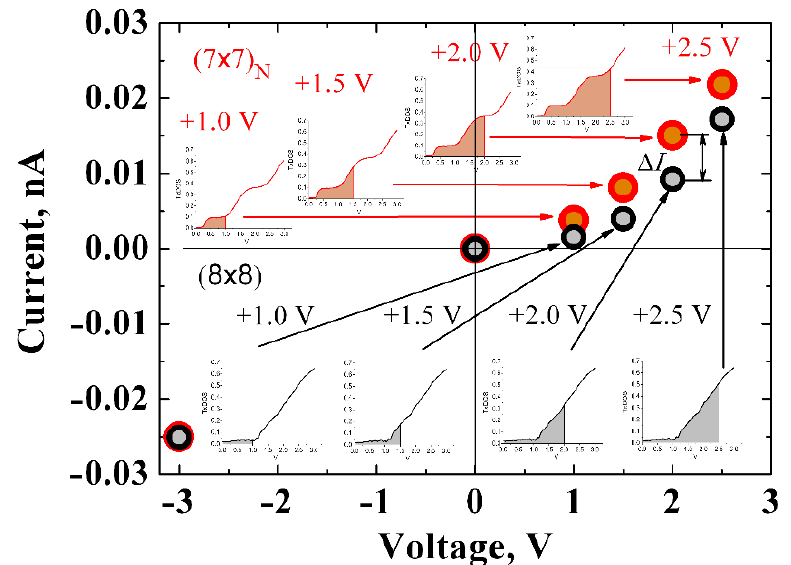
Figure 9. Calculation of the expected tunneling current from different (7 × 7) N and (8 × 8) structures with different densities of states and the fixed tunnel gap as a function of bias.